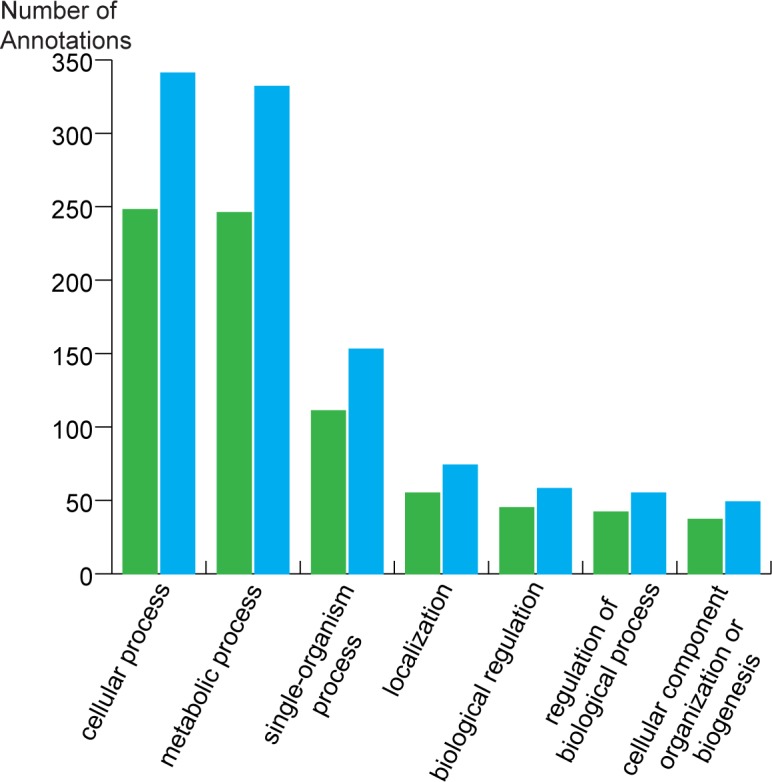
Distribution of biological function annotation of two Hemideina transcriptomes.Green bars: H. crassidens and blue bars: H. thoracica.